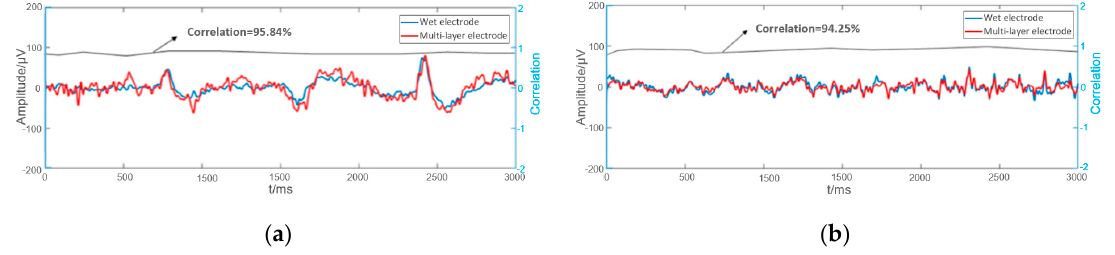
Figure 9. Typical EEG collected under different conditions in the eyes close/open experiment: ( a ) EEG at the Fpz with closed eyes; ( b ) EEG at the Fpz with opening eyes; ( c ) EEG at the Oz with closed eyes; ( d ) EEG at the Oz with opening eyes.